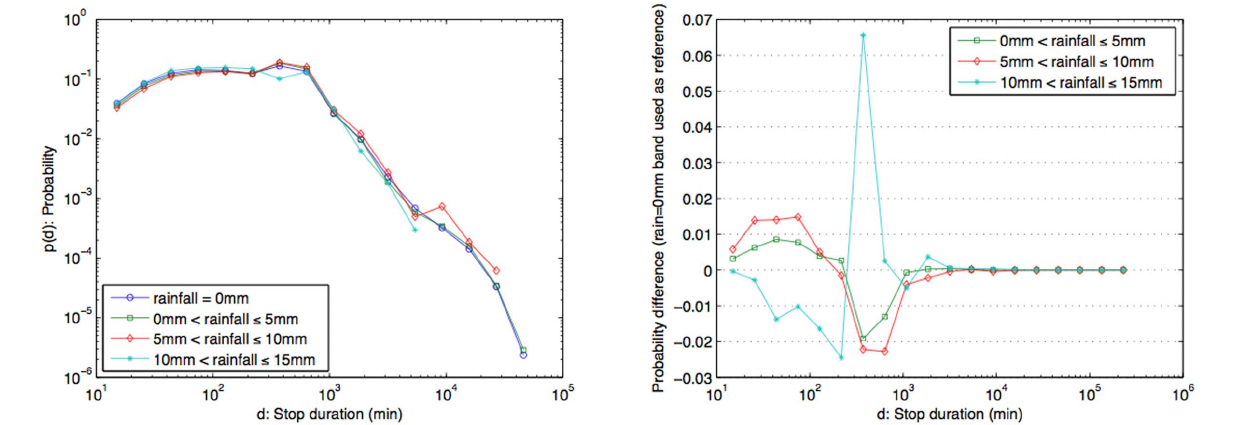
Figure 10. Probability mass function of stop duration under different bands of rainfall and probability difference compared with the band of rainfall =0 mm.